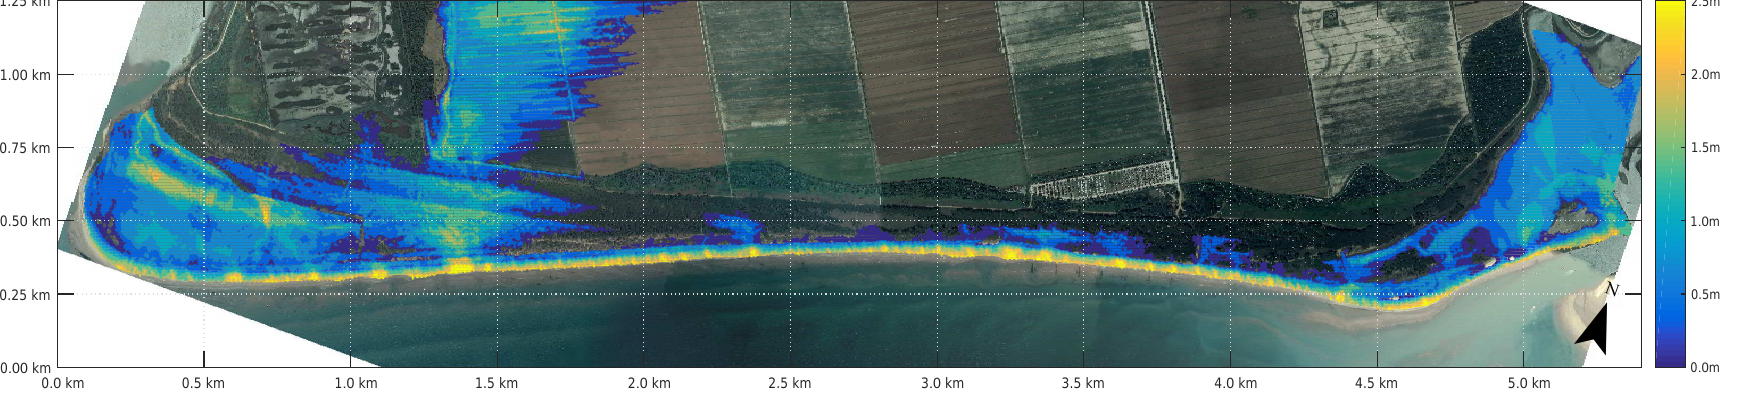
Figure 9. Flooding map (cell VE2): Hs = 6 m, ζ = 1.75 m ZMPS.